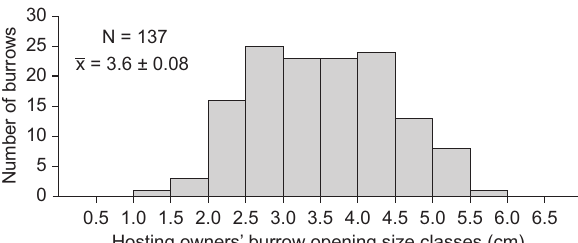
Figure 1. Size-frequency distribution of opening diameter (mean and standard error) of U. cordatus burrows with conspecific co- inhabitant crabs, n =